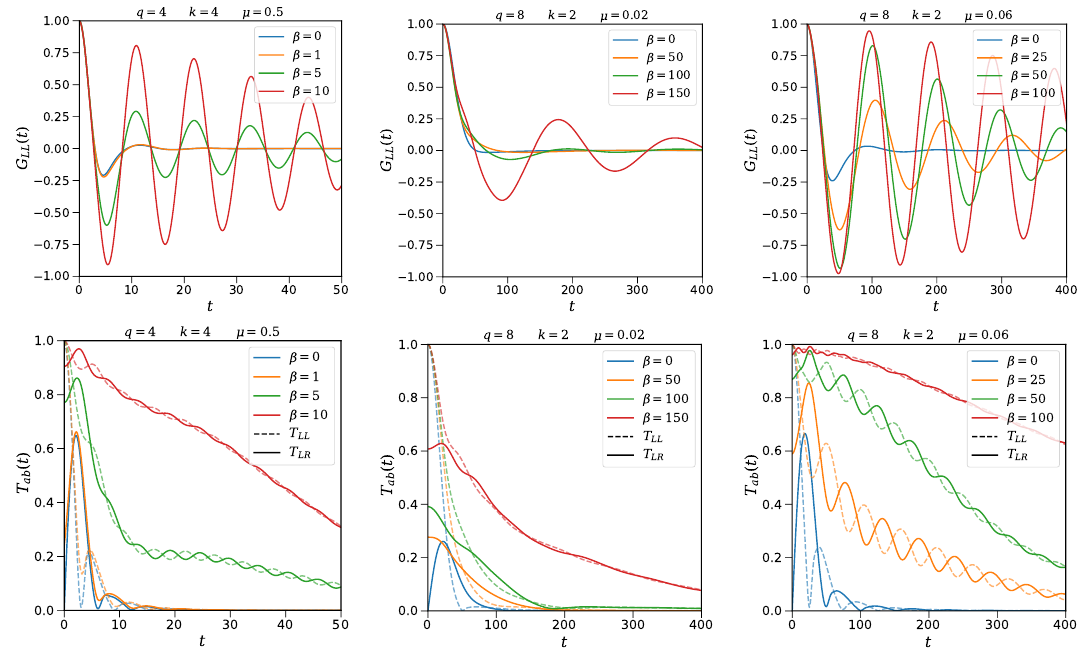
Figure 11. The effect of temperature on real time retarded Green’s function G LL (top) and the corresponding transmission amplitude T ab (bottom) for the two coupled sparse SYK system with 2 N = 40 Majorana fermions and parameters: q = 4 , k = 4 , and µ = 0 . 5 (left); q = 4 , k = 4 , and µ = 0 . 5 (center); q = 4 , k = 4 , and µ = 0 . 5 (right). Each curve is the result of an average over 50 disorder